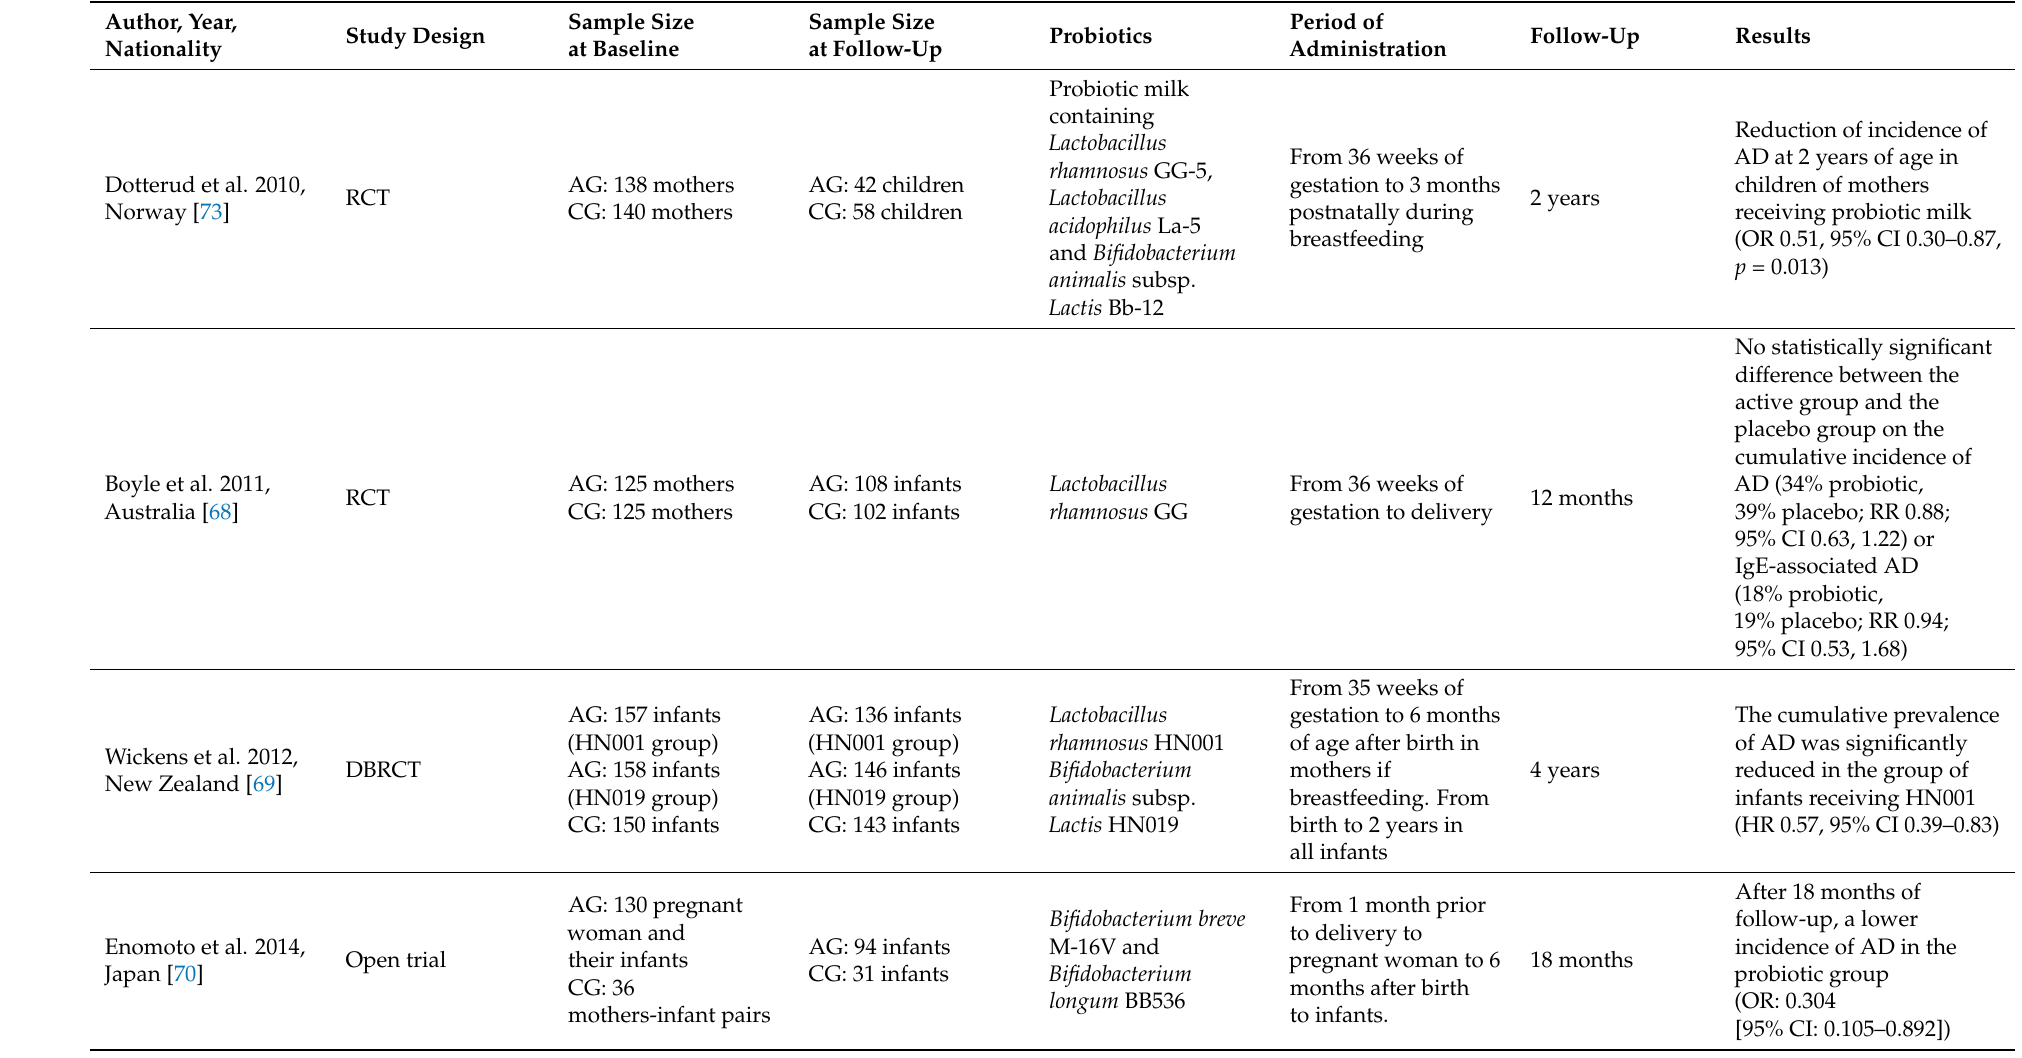
Table 1. Main clinical studies performed with oral probiotics for atopic dermatitis prevention in